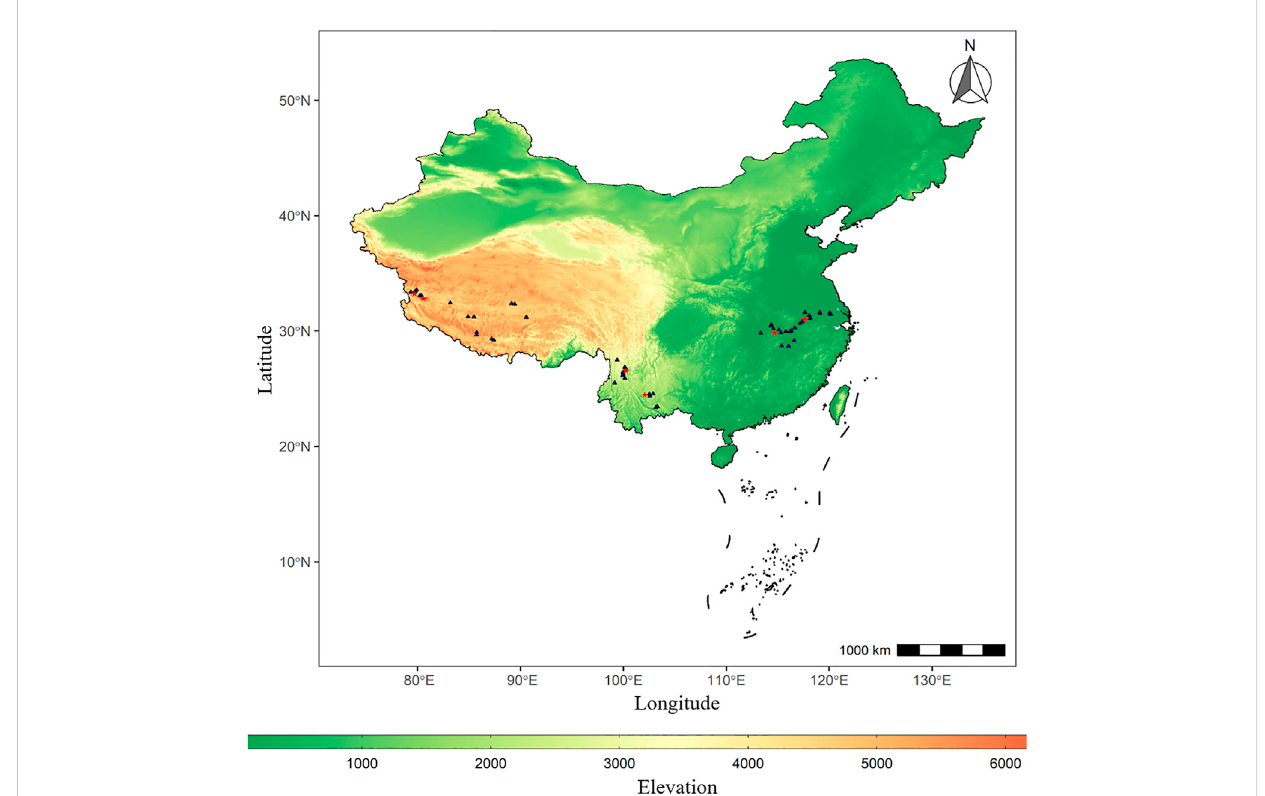
FIGURE 1 Distribution map of lake sites. The points (triangles and fi ve-pointed stars) marked in the map represent the sites distribution of 51 lakes with 16S rRNA gene downloaded from National Center for Biotechnology Information (NCBI), among which the fi ve-pointed stars (red) represent the site distribution of six typical lakes